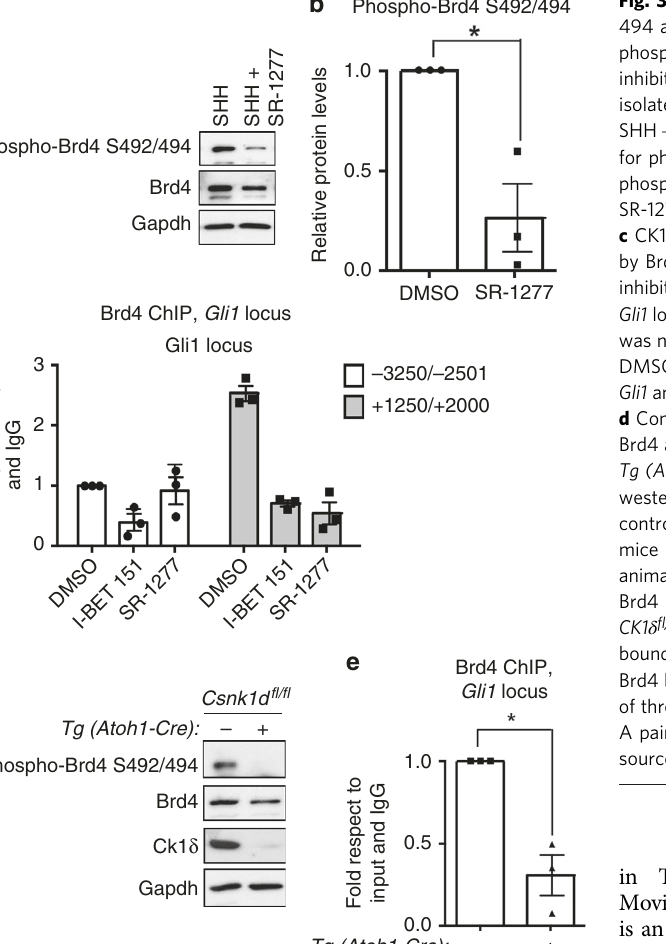
Fig. 3 CK1 δ inhibition or deletion reduces Brd4 phosphorylation on S492/ 494 and binding to the Gli1 locus. a CK1 δ is required for Brd4 phosphorylation in vitro. CK1 δ inhibition via the highly selective CK1 δ inhibitor (SR1277) reduces Brd4 phosphorylation at S492/494. GCPs